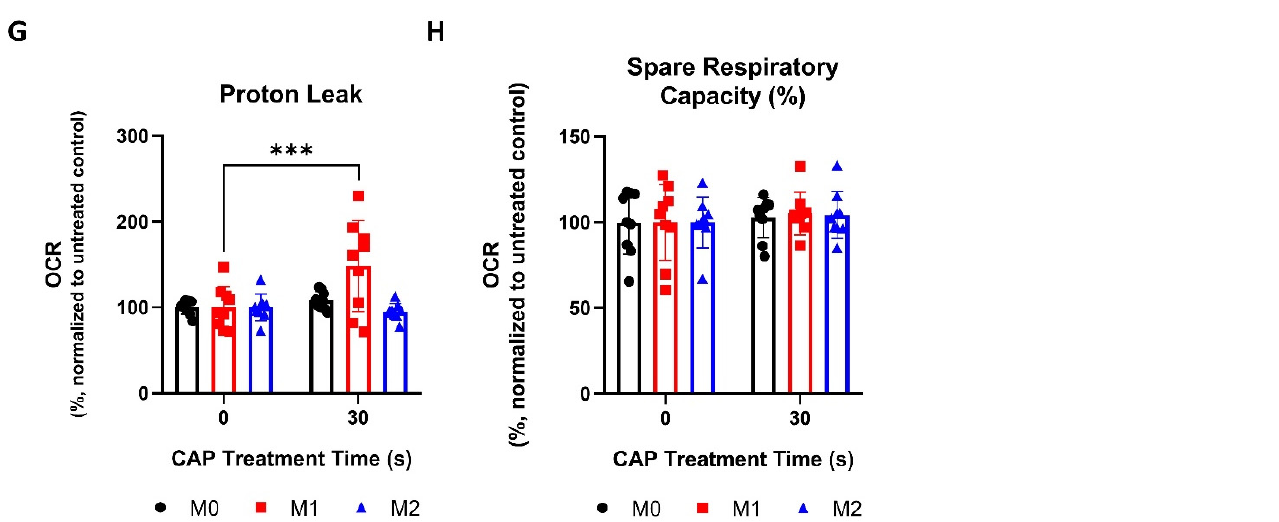
Figure 5. CD4 + and CD8 + T cells are more sensitive to CAP-induced mitochondrial stress than macrophages. ( A – D ) CD4 + and CD8 + T cells were treated with 30 s of CAP 1 h before undergoing Seahorse Cell Mito Stress Tests. The data from each of the following parameters, ( A ) ATP-production coupled respiration, ( B ) coupling efficiency (%), ( C ) proton leak, and ( D ) spare respiratory capacity (%), show the mean ± SD ( n = 3 donors); statistical significance was calculated by performing unpaired Student’s t -tests; ( E – H ) macrophages were treated with 30 s of CAP 1 h before undergoing Seahorse Cell Mito Stress Tests. The data from each of the following parameters, ( E ) ATP-production coupled respiration, ( F ) coupling efficiency (%), ( G ) proton leak, and ( H ) spare respiratory capacity (%), show the mean normalized to the untreated control ± SD ( n = 9, 3 donors with 3 replicates each); statistical significance was calculated by performing two-way ANOVAs corrected for multiple comparisons with Dunnett tests and is indicated by the asterisks as follows: * p < 0.05; ** p < 0.01; *** p < 0.001; **** p <